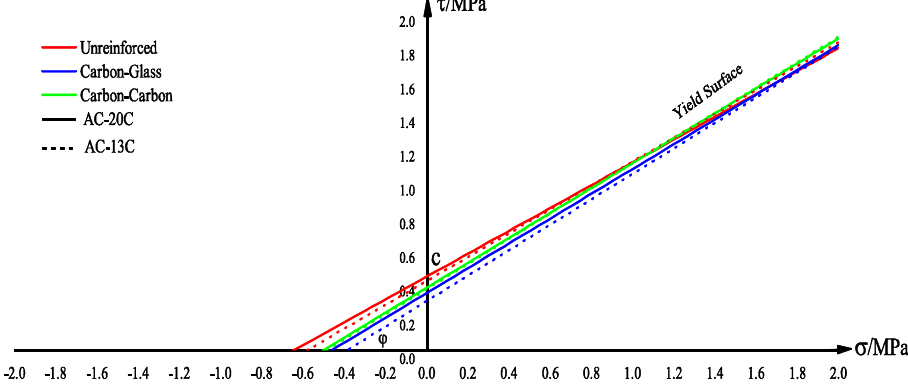
Figure 9. τ - σ image from the direct shear and oblique shear tests. Figure 9. τ-σ image from the direct shear and oblique shear tests.